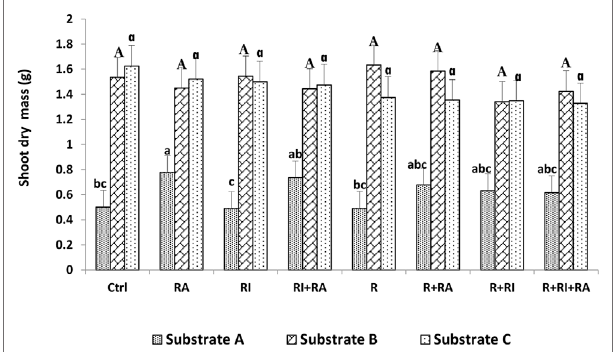
FIGURE 3 | Shoot dry mass of S. senegal seedlings that were grown on differentinoculated oruninoculated substratesinnursery conditions. Foreach